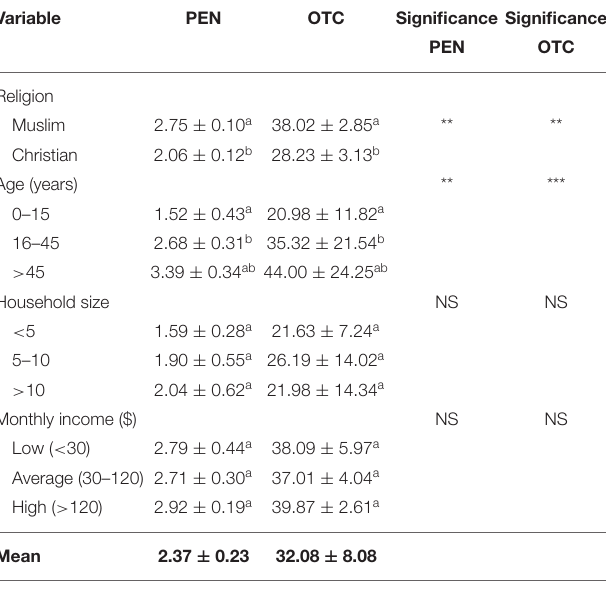
TABLE 2 | Daily intake ( µ g) of antibiotic residues per capita in Maroua.